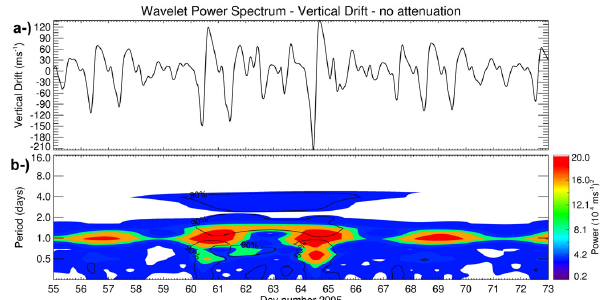
Fig. 2. (a) vertical drifts calculated by the CODB model consid- ering the case where the UFK wave propagated upwards without attenuation. (b) wavelet power spectrum.